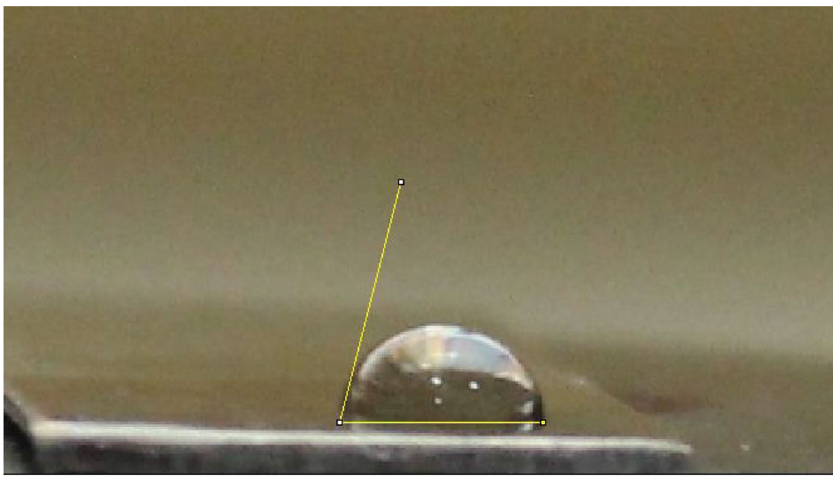
Fig. 7 Photograph of water droplet placed on GO coated 304SS after prolonged corro- sion (θ =